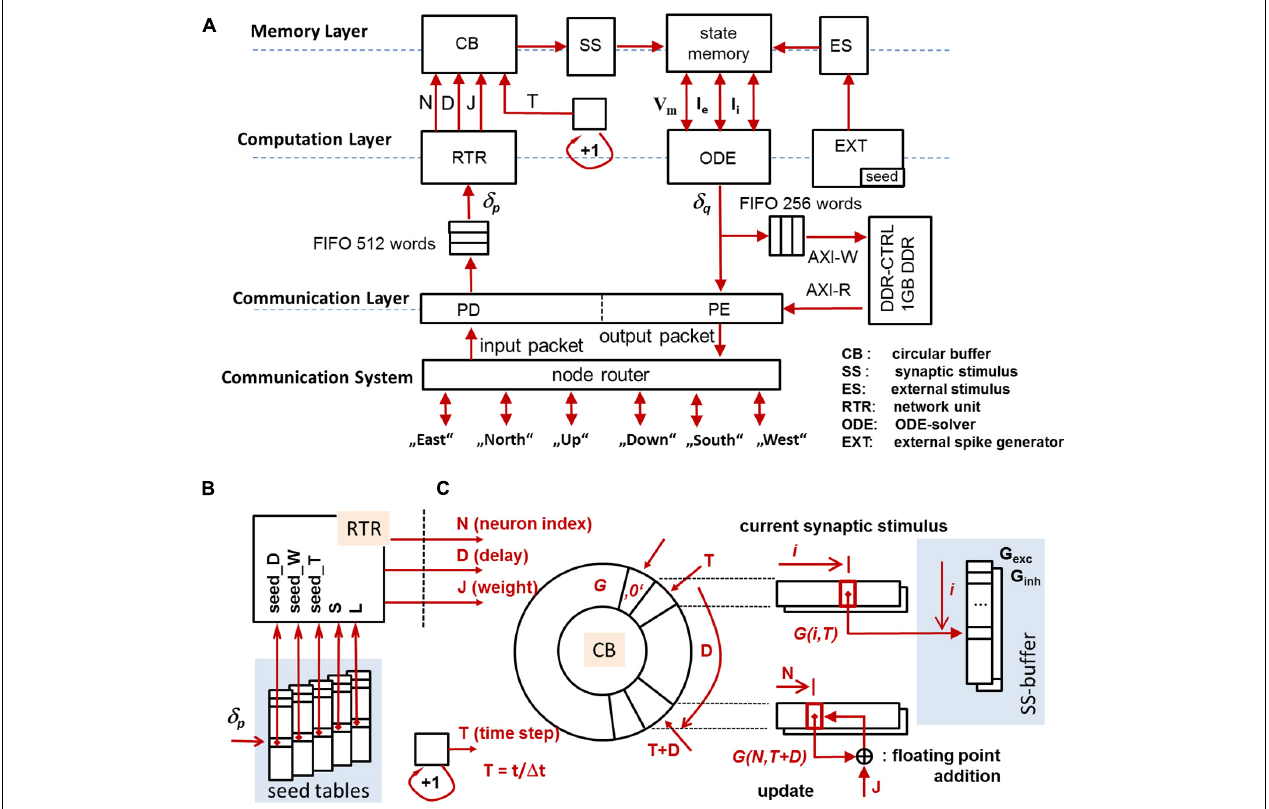
FIGURE 3 | Overview of the CN-architecture (A) , seed tables for the MTBRNG-based RTR unit (B) , addressing scheme for the circular buffer (C) . The circular buffer preserves the forcing terms of synaptic activity to be effective in a future time step.